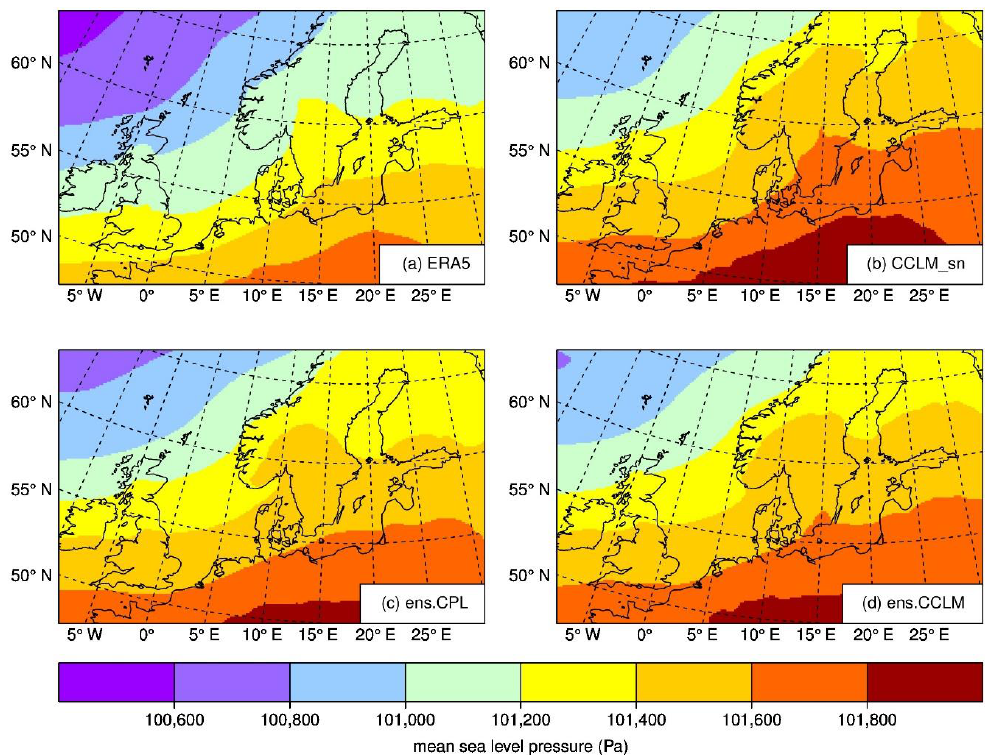
Figure 4. Mean sea level pressure MSLP mean (Pa) of ( a ) ERA5, ( b ) CCLM_sn, ( c ) ens.CPL and ( d ) ens.CCLM. Time period: 1 September–31 October 2013. Focus is on the NS_BS area of Figure